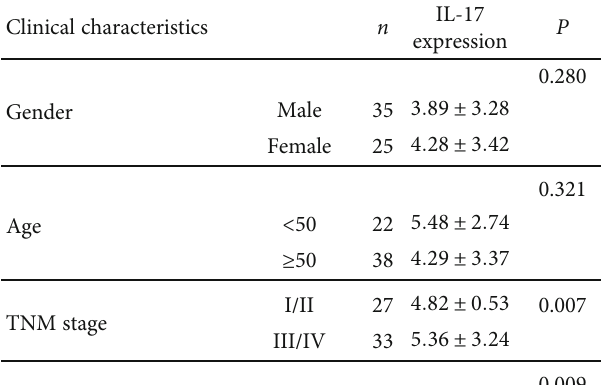
Table 2: Correlations of IL-17 expression with clinical characteristics in patients with LC. Clinical characteristics